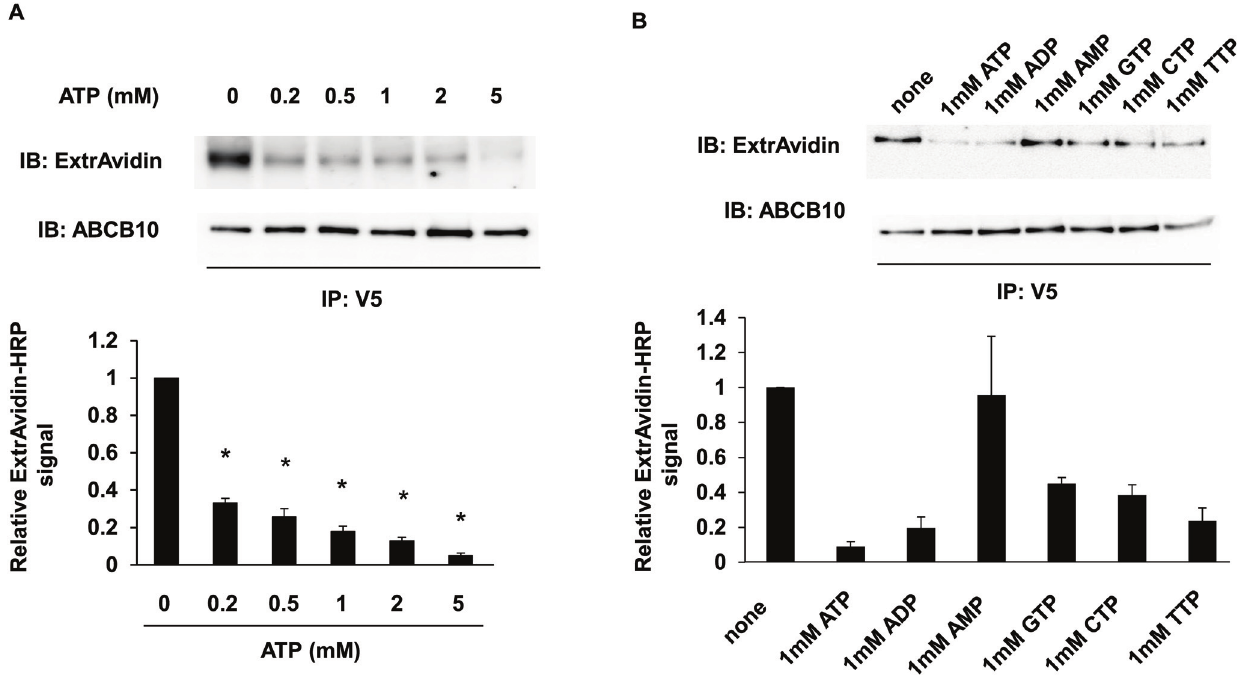
Fig 3. Unlabeled ATP, ADP, GTP, CTP and TTP compete with 8-azido-ATP for ABCB10 binding. A) Increasing concentrations of unlabeled ATP decreased 8-azido-ATP [ γ ] biotin photolabeling detected with Extravidin-HRP, indicating that the 8-Azido-ATP binding to ABCB10 is specific. Bar graphs show the relative ExtrAvidin-HRP signal per 8-azido-ATP concentration ( μ M). Three independent experiments were conducted and data are shown as mean ± SEM. * p < 0.05 vs. signal in 0 mM ATP treatment. B) ATP and ADP had the strongest competition with 8-azido-ATP [ γ ] biotin to bind to ABCB10. GTP, CTP and TTP could also compete with 8-azido-ATP [ γ ]biotin for ABCB10 binding but to a lower extent. AMP did not compete for binding, as expected for an ABC protein. A representative Western blot analysis is shown and bar graphs represent mean ± SD from independent competition